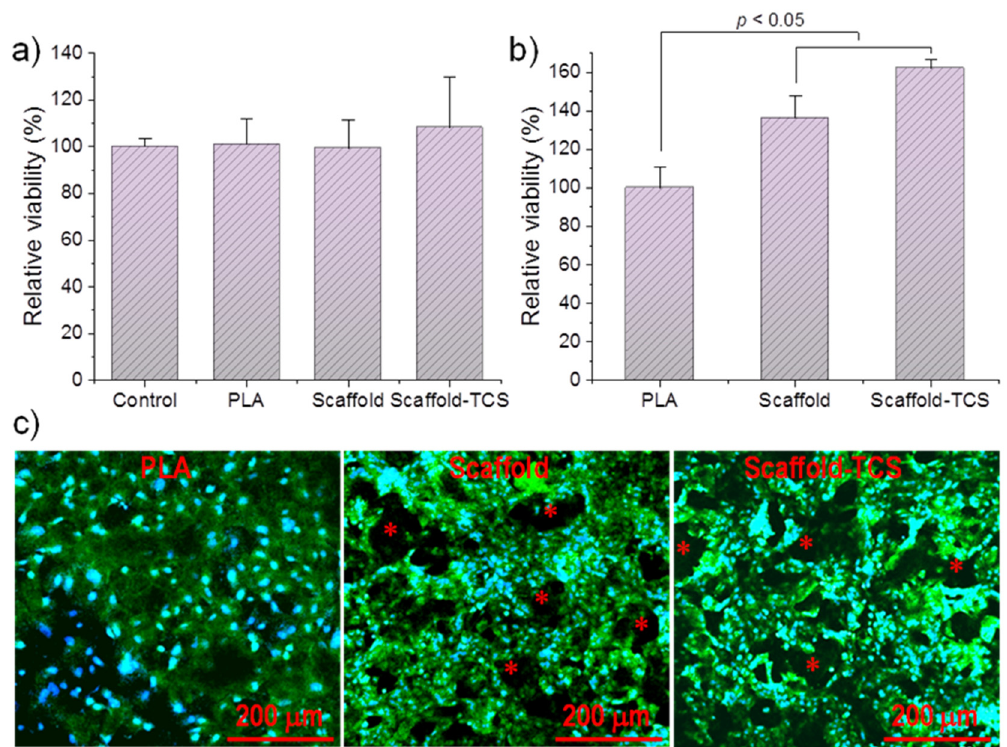
Figure 16. ( a ) Cell viability in the presence of the micro-molded specimens. Control corresponds to cell growth in the absence of any specimen. ( b ) Relative cell proliferation at 7 days after seeding on non-porous PLA, PLA scaffold and PLA scaffold loaded with 6 wt-% of TCS. ( c ) Fluorescence micrographs of the three indicated samples after the cell proliferation assay. The cells were stained for nuclei (DAPI, blue) and actin (phalloidin, green). Asterisks indicate scaffold porous.